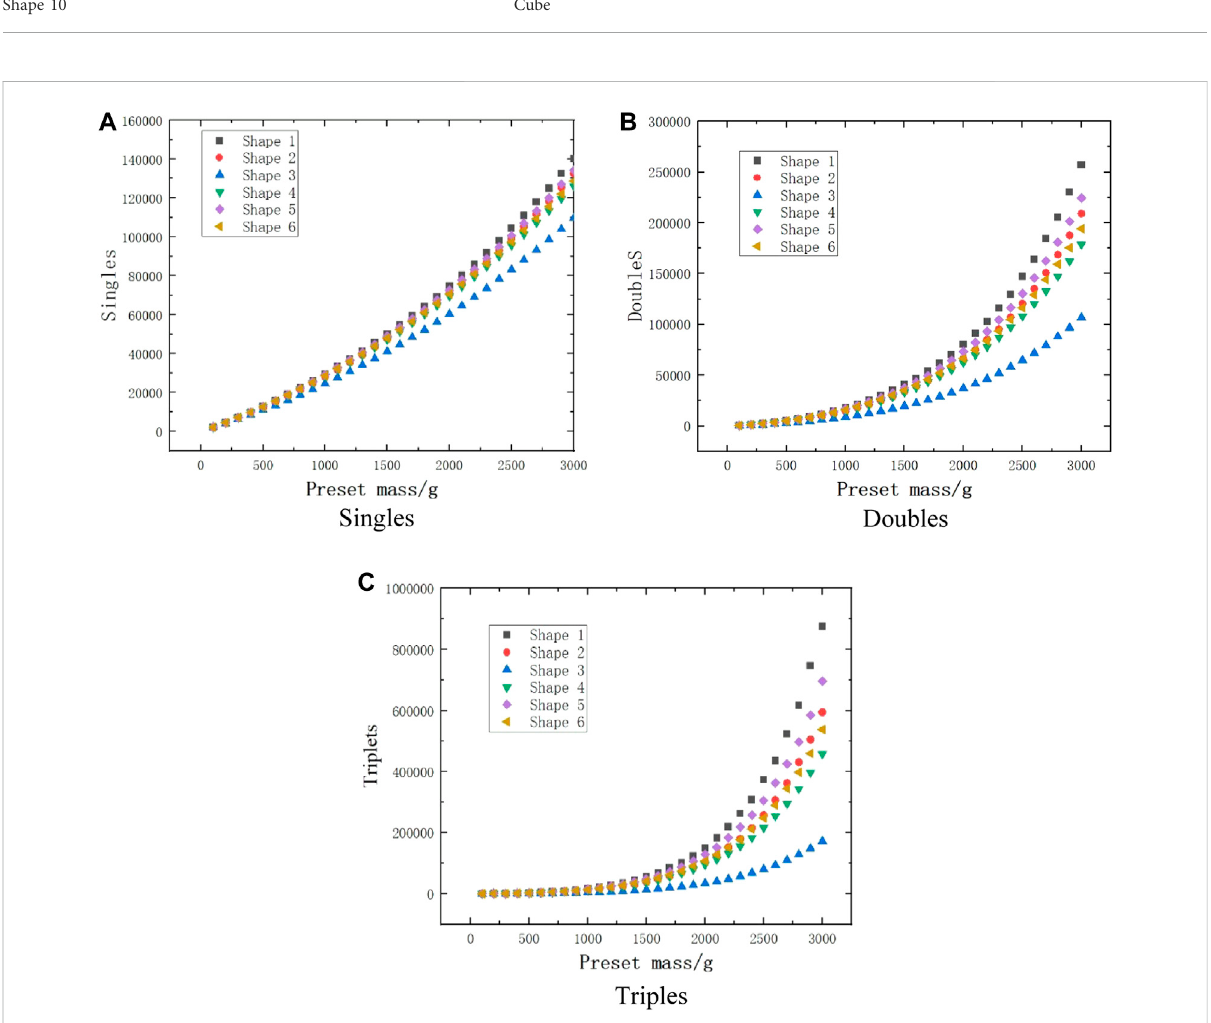
FIGURE 3 Variation of three count rates with mass for different shapes. (A) Singles. (B) Doubles. (C)